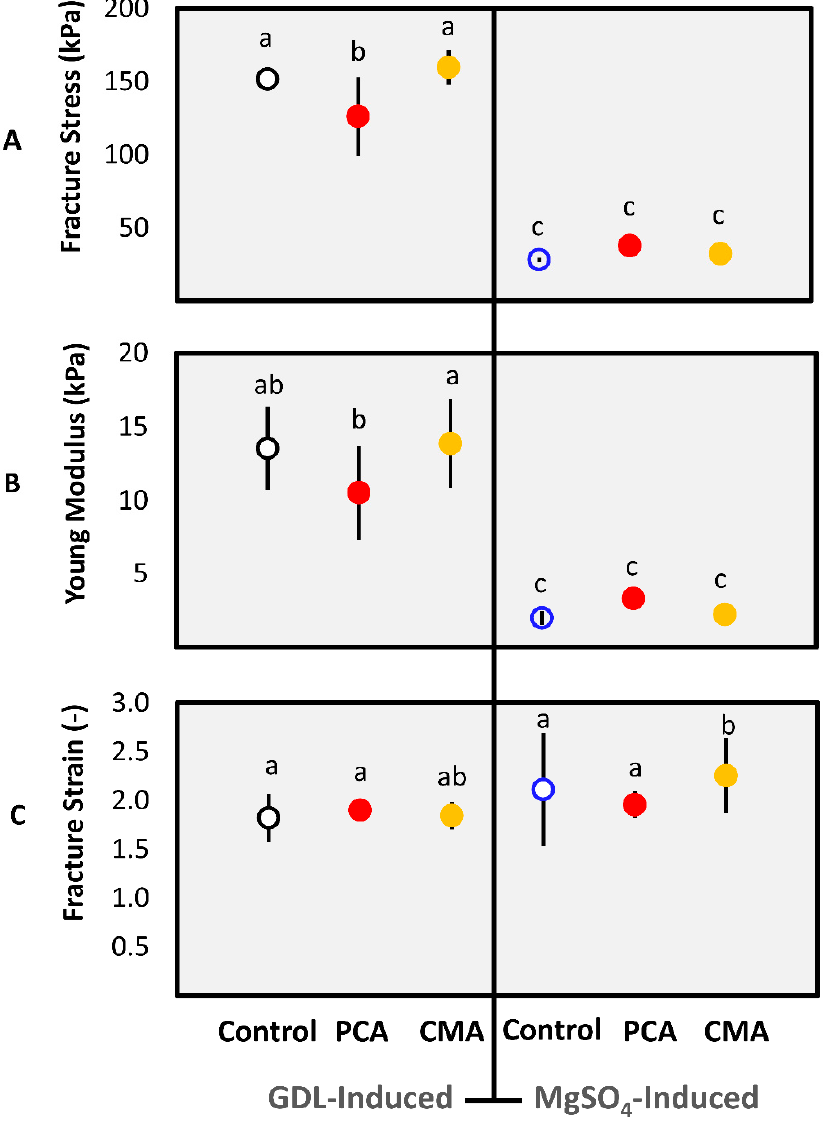
Figure 1. Textural properties of pressed soy protein gels induced by GDL and MgSO4 with added phenolic acids: ( A ) Fracture stress (kPa), ( B ) Young’s modulus (kPa), and ( C ) fracture strain, at 80% of deformation. The red color bullets indicate the addition of the PCA and the yellow the addition of CMA. Values were represented as means ± standard deviations ( n ≥ 8). Different letters indicate significant differences ( p ≤ 0.05).